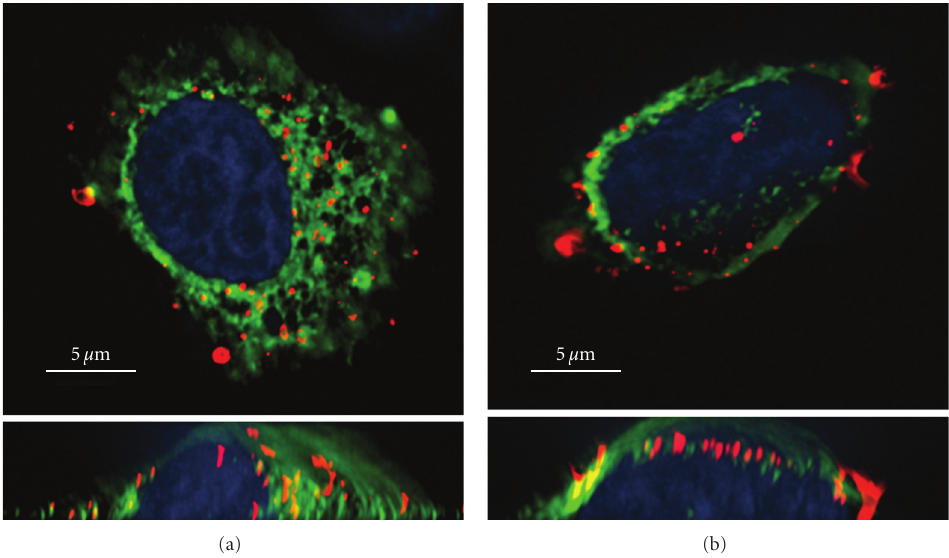
Figure 2: Dynamin-2 regulates OxLDL endocytosis. Epithelial HeLa cells expressing both LOX-1-FLAG and either (a) wild-type dynamin 2 (green) or (b) a dynamin-2 K44A mutant (green) were incubated and chased with labelled Dil-OxLDL (red). Cells were fixed and processed for fluorescence microscopy using previously described procedures [26]. The nuclei were stained with DAPI (blue). Bar, 5 μ m. A slice through the cell is shown in the top half of the panel and a cross-section through the cell is shown at the